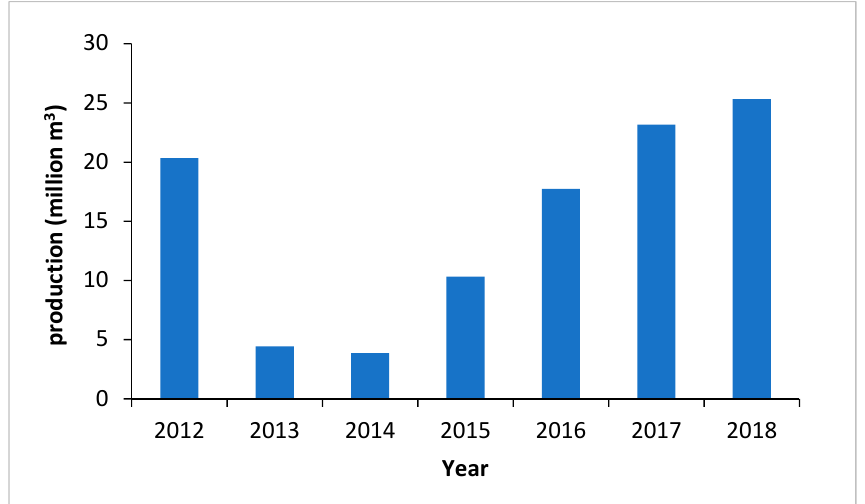
Figure 3. Annual desalinated water production (million m 3 ) from 2012 to 2018.